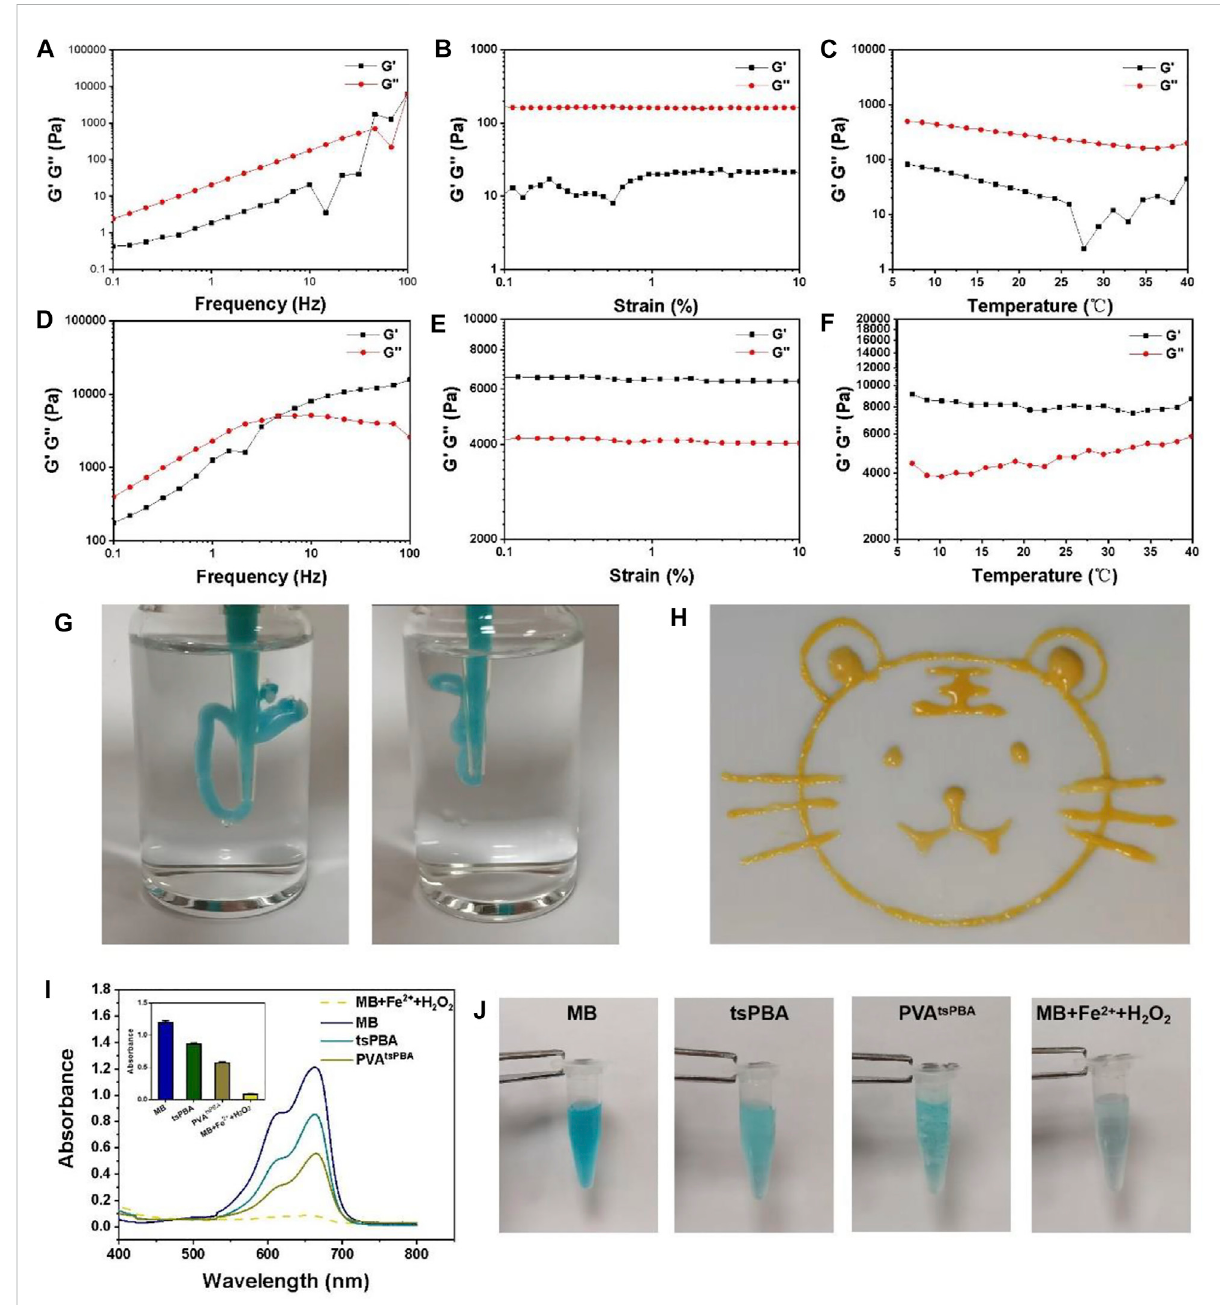
FIGURE 2 (A) Frequency spectra of G ’ (storage modulus) and G ” (loss modulus) of PVA. (B) Strain sweep measurements of G ′ and G ″ of PVA. (C) Evolution oftheG ′ andG ″ overtemperatureforPVA. (D) FrequencyspectraofG ′ andG ″ ofPVA tsPBA . (E) StrainsweepmeasurementsofG ′ andG ″ ofPVA tsPBA . (F) EvolutionoftheG ′ andG ″ overtemperatureforPVA tsPBA . (G) Photographoftheinjectablehydrogel. (H) PaintingofatigerdrawnbyPVA tsPBA througha pipette. (I) UV-visabsorptionspectraofMBtriggeredbyFentonreactiondegradationwithtsPBAandPVA tsPBA .Theaverageoftheabsorbanceof MB, tsPBA, PVAtsPBA, and MB + Fe 2+ +H 2 O 2 in 663 nm n = 3 (J) The photographs of MB in Fenton reaction solution incubated with tsPBA and PVA tsPBA